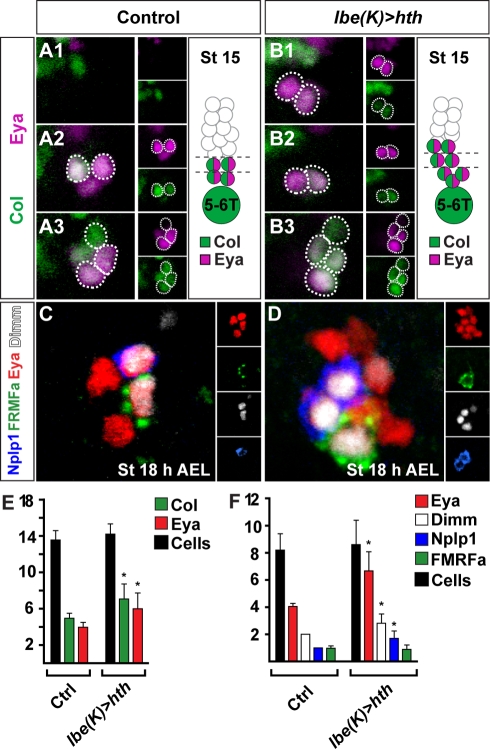
Overexpression of homothorax triggers the Ap window by activating collier.(A and B) Images showing expression of Col and Eya within the dorsal (A1 and B1), intermediate (A2 and B2), and ventral (A3 and B3) part of the NB 5-6T lineage; shown are top views, with anterior up. Cartoons represent the NB 5-6T lineage, based upon lineage mapping data [35]. Small boxes show the expression of Eya and Col in separate panels. In control, Ap cluster neurons coexpress Col and Eya at stage 15 and occupy intermediate (A2) and ventral (A3) layers, close to the neuroblast. In hth overexpression embryos, ectopic Col and Eya expressing cells appear in the intermediate (B2) and dorsal (B1) layers of the NB 5-6T lineage. (C and D) Expression of Eya, Dimm, Nplp1, and FMRFa within single T2 Ap clusters at stage 18 h AEL; shown are side views, with anterior to the left. Small boxes show the expression of Eya, Dimm, Nplp1, and proFMRFa in separate panels. (C) In control, Eya is specifically expressed within the four Ap cluster neurons, and Nplp1/Dimm and FMRFa/Dimm are expressed within Ap1/Nplp1 and Ap4/FMRFa neurons, respectively. (D) When hth is overexpressed within the NB 5-6T lineage, extra Eya, Dimm, and Nplp1 expressing cells appear. (E) Quantification (n>8 VNCs) of Col and Eya cell numbers, at stage 15, and NB 5-6 T lineage cell numbers, at stage 14. (F) Quantification (n>8 VNCs) of Eya, Nplp1, Dimm, FMRFa, and NB 5-6 T lineage cell numbers at stage 18 h AEL. Values as mean number of expressing cells within single NB 5-6T lineages, error bars show SD. Asterisks (*) denote significant difference compared to control (p<0.01, Student two-tailed t-test). Genotypes: (A, C, and E) lbe(K)-Gal4/+. (B, D, and F) UAS-hth/+; lbe(K)-Gal4/+.